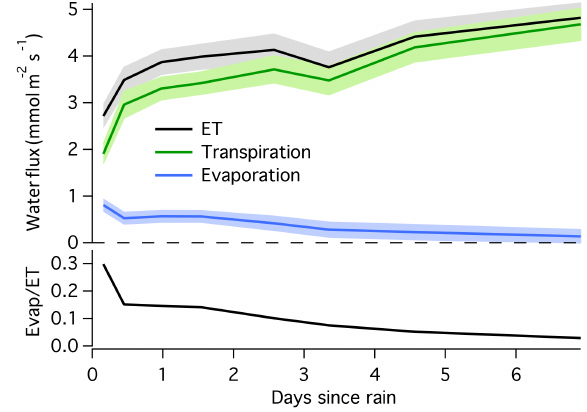
Figure 8. Daytime evapotranspiration, transpiration, evaporation, and the ratio of evaporation to evapotranspiration versus time since the cessation of